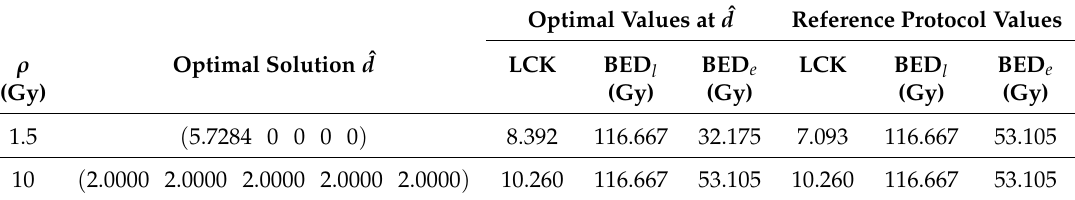
Table 5. Comparison of LCK, BED l and BED e between the reference protocol ( ¯ ω = 7, ¯ d = 2 Gy) and the optimal solution to Problem 1 in the absence of incomplete repair. Parameters: ρ = 1.5 Gy, α = 0.1 Gy − 1 , T P = 40 days, and T k = 300 days; ρ = 10 Gy, α = 0.35 Gy − 1 , T P = 3 days, and T k = 21